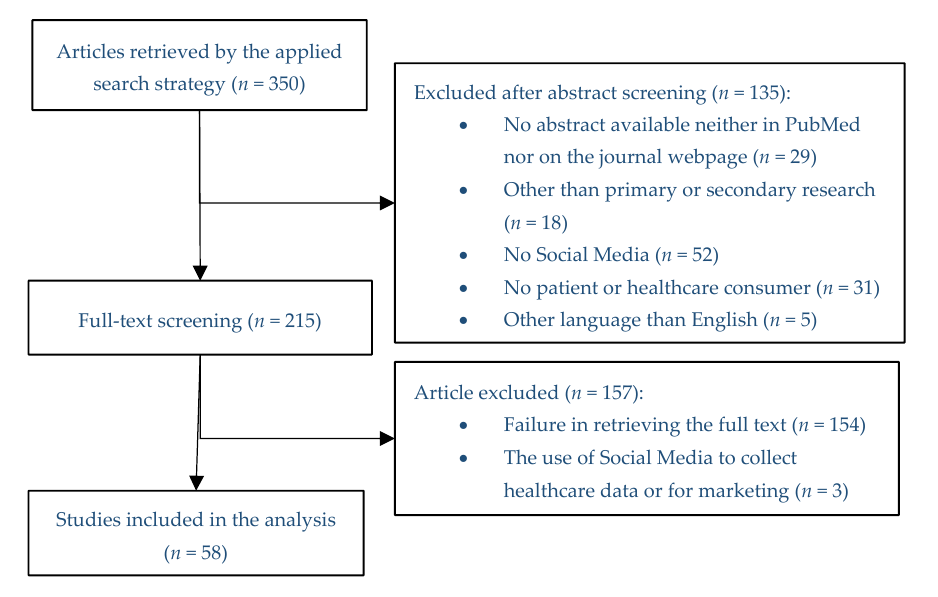
Figure 2. Flowchart diagram of the selection procedure.